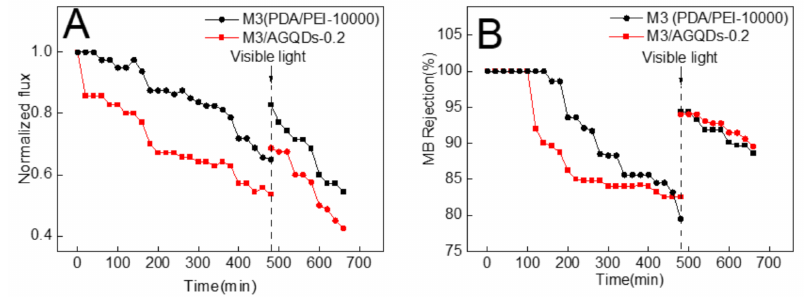
Figure 12. Photocatalytic self-cleaning properties of the prepared membranes: ( A ) normalized water fluxes and ( B ) MB rejection before and after